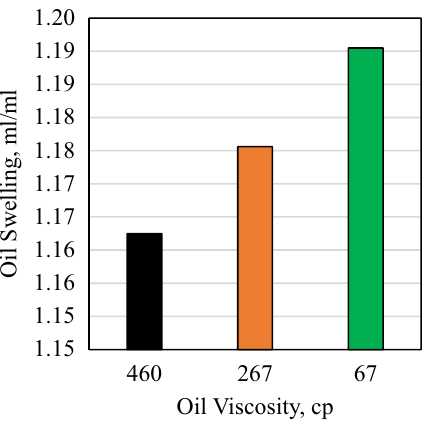
Fig. 5 Effect of oil volume on oil swelling at 1500 psi and 40 °C using 470 cp